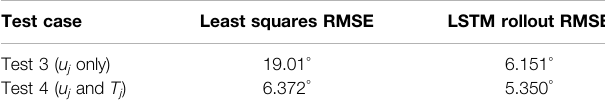
TABLE 1 | Comparison of RMSE of least squares fi t vs. learned model rollout, bidirectional